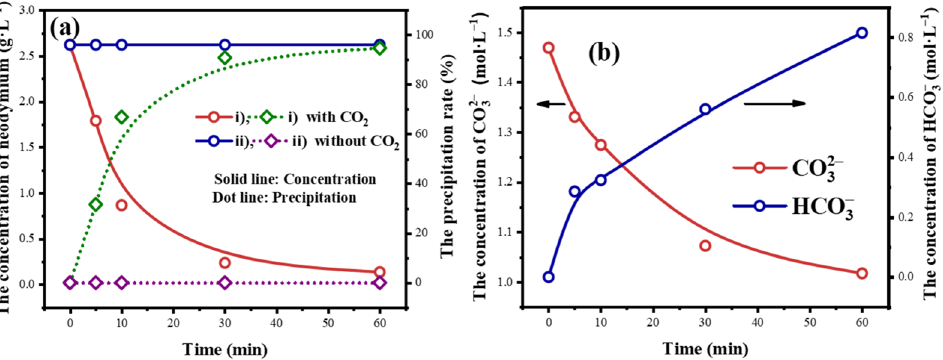
Figure 8. The concentration of dissolved Nd 3+ in the solution and the precipitation rate with the ventilation time of CO 2 ( a ), and the concentration of CO 32 − /HCO 3 − with the ventilation time of CO 2 ( b ).